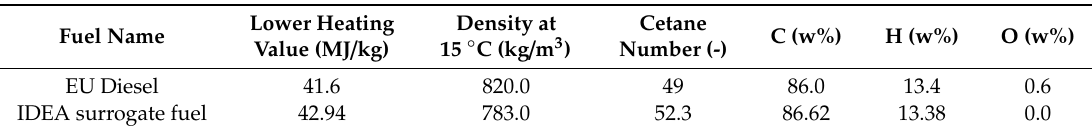
Table 4. SRM main model settings for the heavy-duty Diesel engine simulation campaign. Parameter